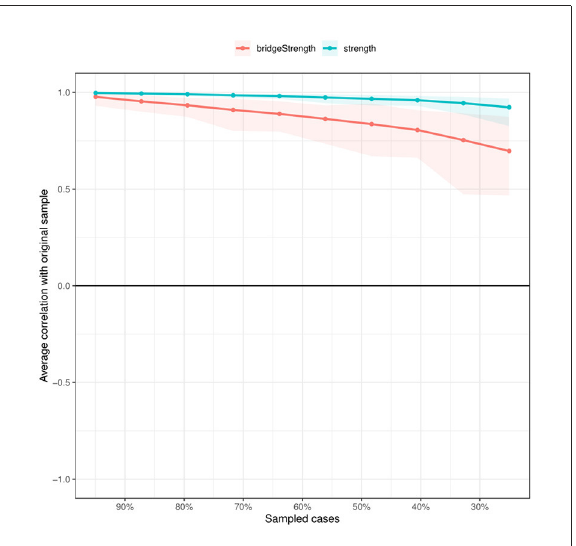
FIGURE3 The case dropping subset bootstrap improves network structure stability. The x-axis shows the proportion of original sample cases included at each step. The y-axis shows the average of the correlations between the original network’s centrality indices and the networks that were re-estimated after eliminating increasing percentages of